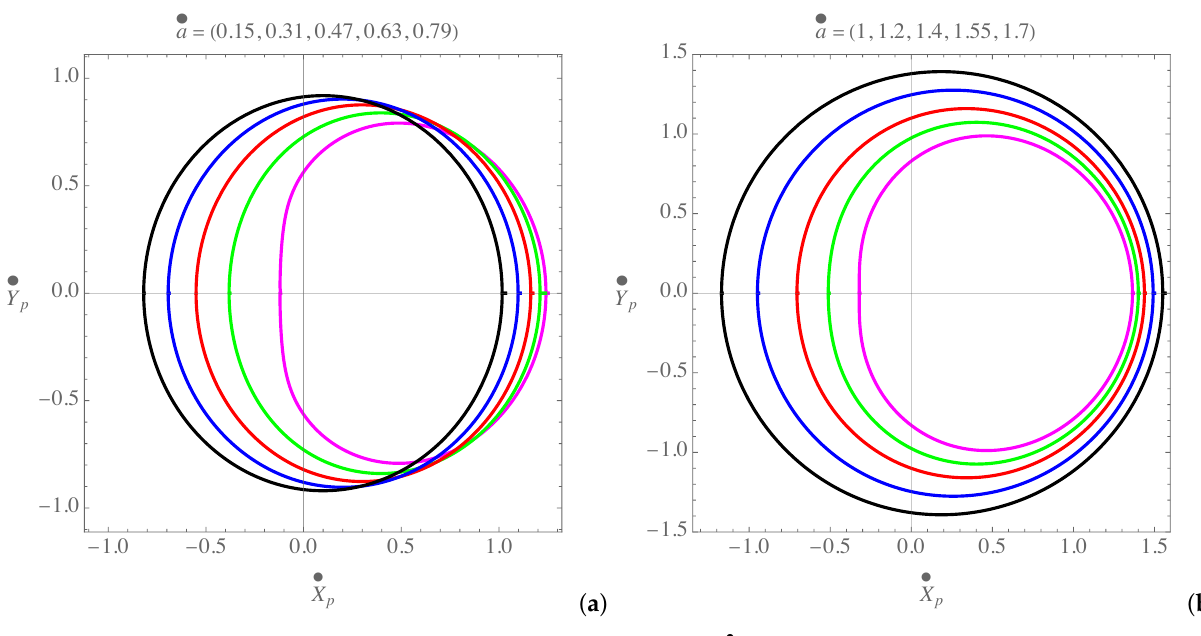
• • Q = 6, r o = 5 and θ o = π /2, for both of the black